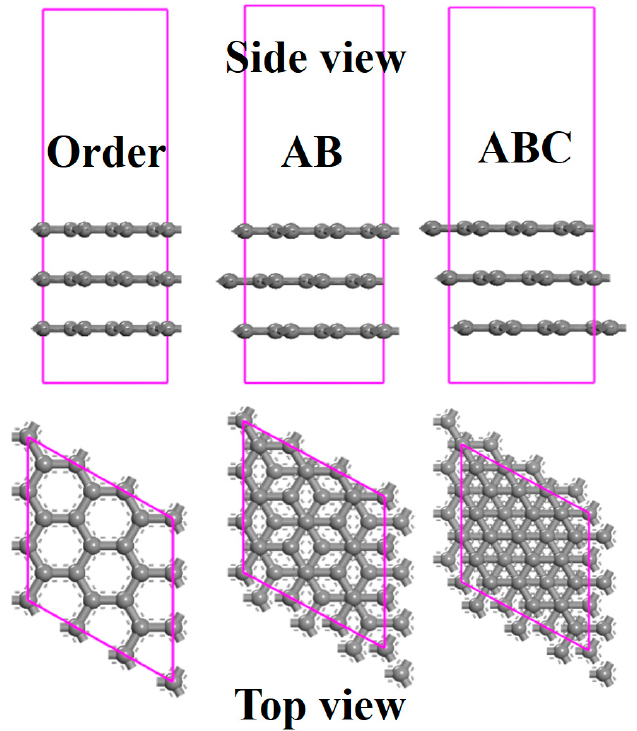
Figure 2. The side and top views of the stacked graphenes with Order, AB, and ABC pattern.